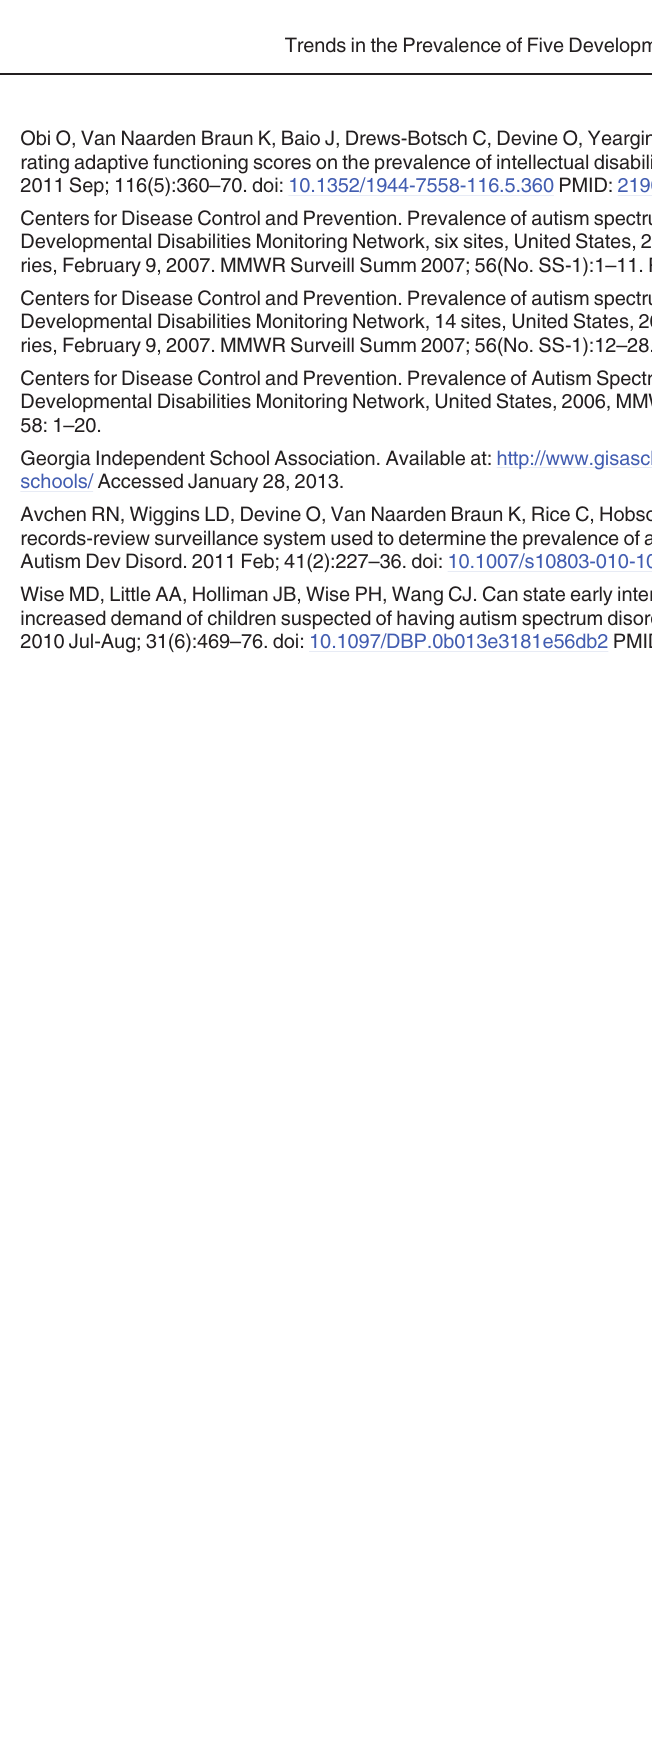
PLOS ONE | DOI:10.1371/journal.pone.0124120 April 29,